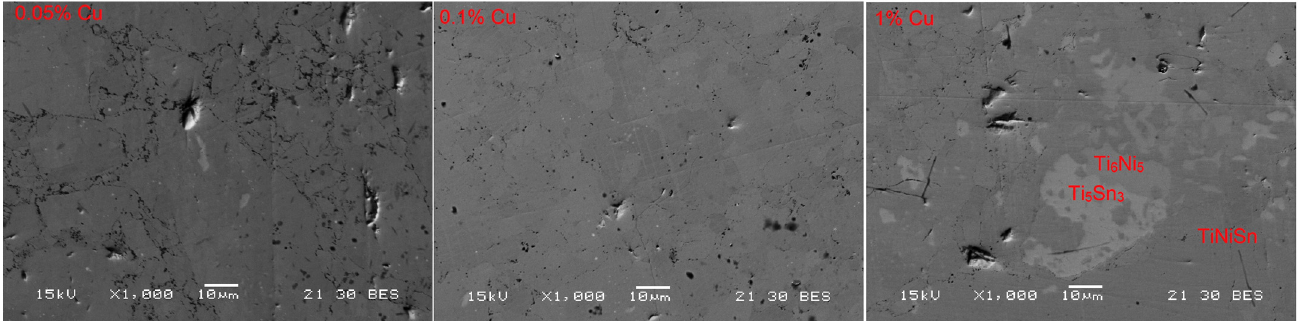
Figure 3. XRD of the TiNi 1- x Cu x Sn after heat treatments showing a single phase up to 1% Cu, with the Ti 6 Sn 5 and Ti 5 Sn 3 phases marked. Black—0% Cu, Red—0.05% Cu, Blue—0.1% Cu, Pink—1% Cu.